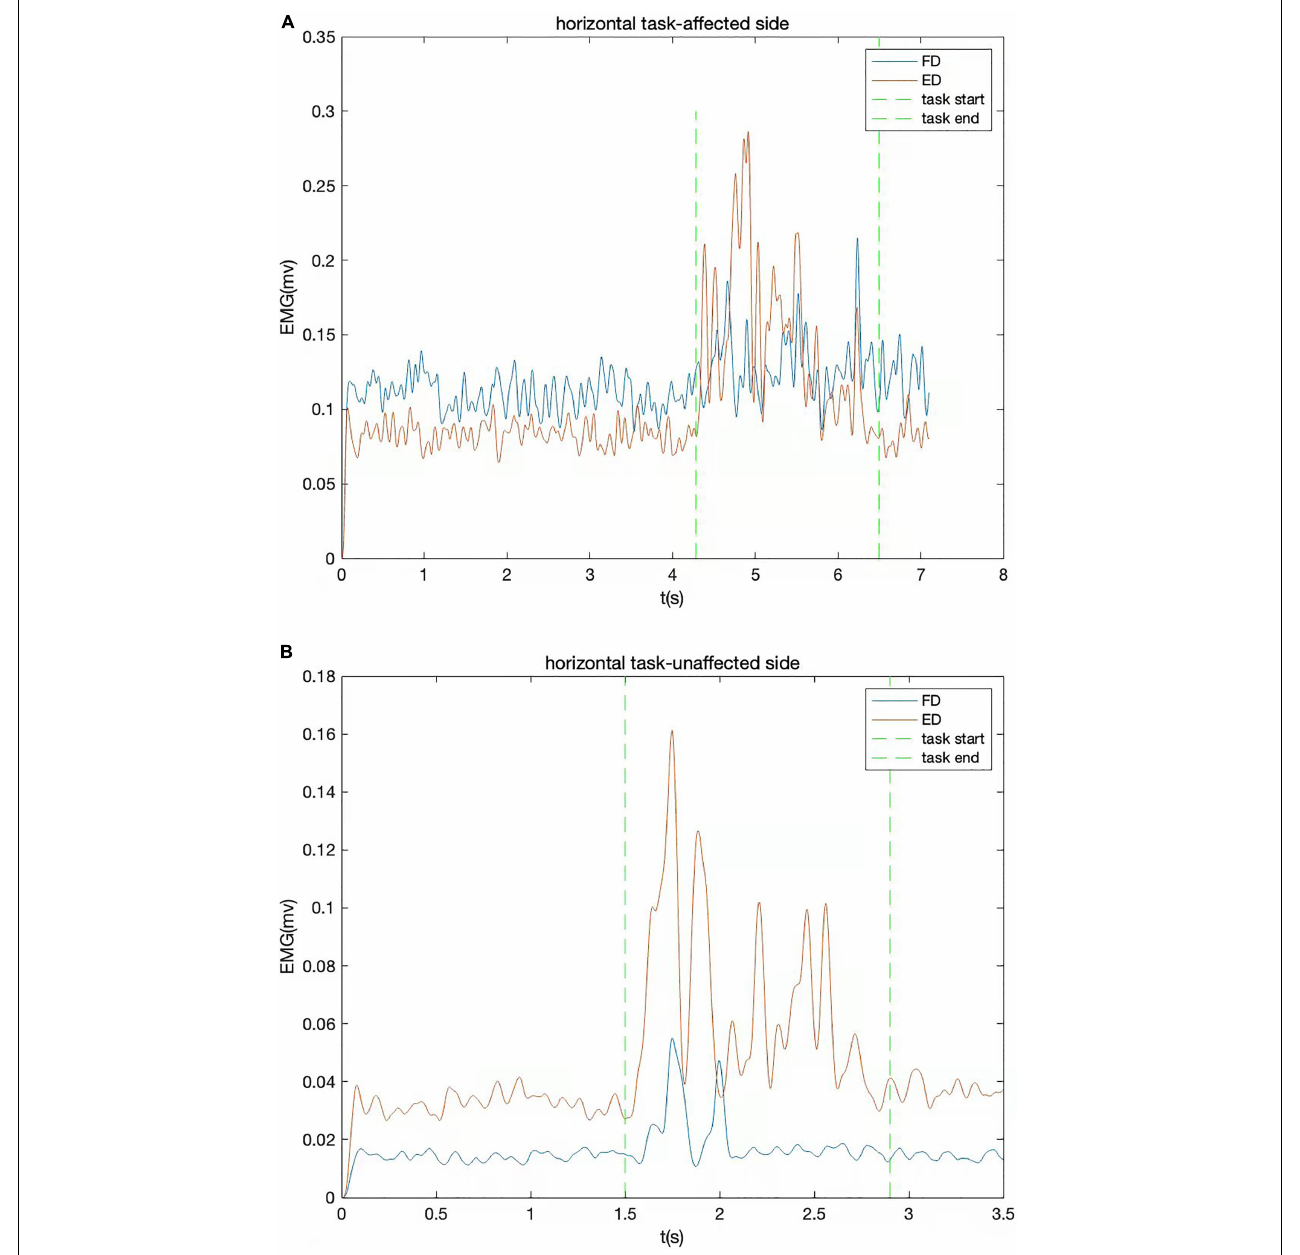
FIGURE 2 | The EMG signals of a typical trial from one stroke survivor captured during horizontal task. The EMG signal of flexor digitorum (FD) and extensor digitorum (ED) are shown together. (A) Affected side; (B) unaffected